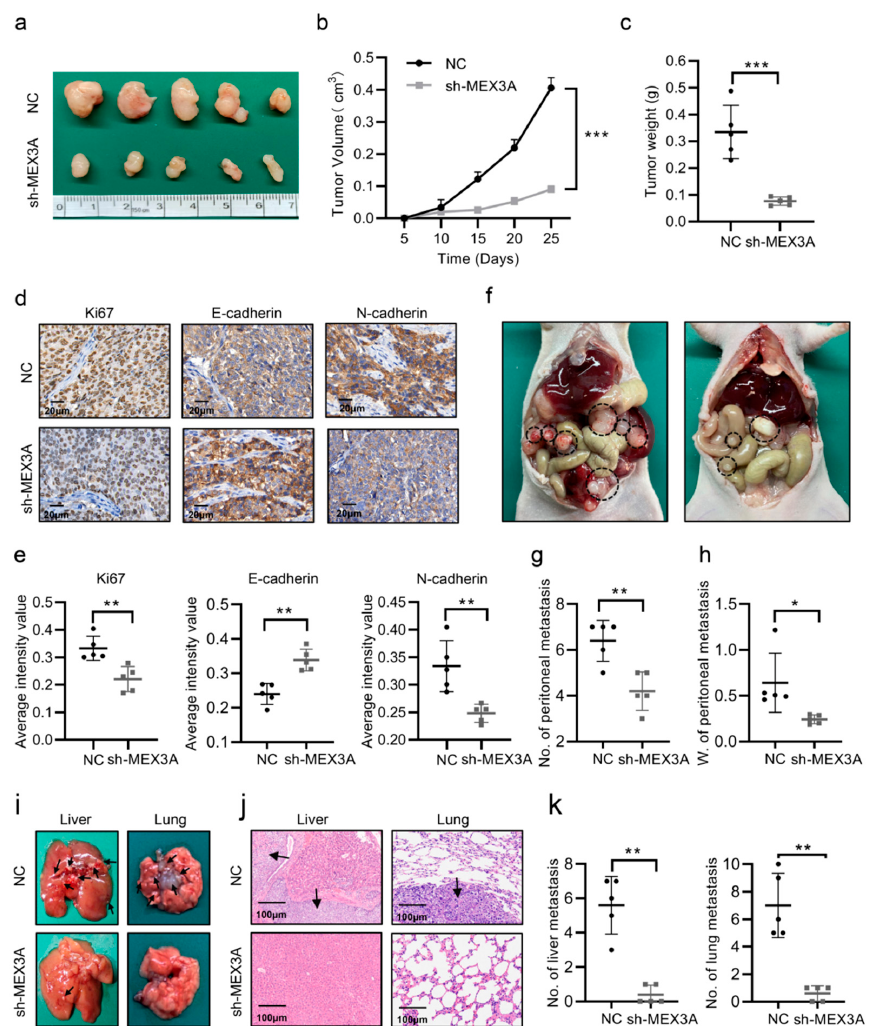
Figure 3. MEX3A increases the oncogenesis and progression of EC cells in vivo. ( a ) Growth of subcutaneous xenografts from control and MEX3A-knockdown cells. ( b ) The tumor volume of the subcutaneous xenografts was detected every 5 days. ( c ) After 25 days, the tumors were re- moved, weighed, and embedded in paraffin. ( d , e ) IHC staining of subcutaneous xenografts for Ki-67, E-cadherin, and N-cadherin. Scale bar, 20 µ m. ( f ) Peritoneal metastasis model in nude mice injected with NC or sh-MEX3A cells. Black circles indicated the location of the metastatic nodules. ( g , h ) Numbers and weights of peritoneal metastases. ( i ) Representative images of metastatic sites in the liver and lung. Black arrows showed the location of the metastatic nodules. ( j ) HE staining of metastatic sites in the liver and lungs. Scale bar, 100 µ m. ( k ) Number of metastatic nodules in the liver and lungs. * p < 0.05, ** p < 0.01, *** p